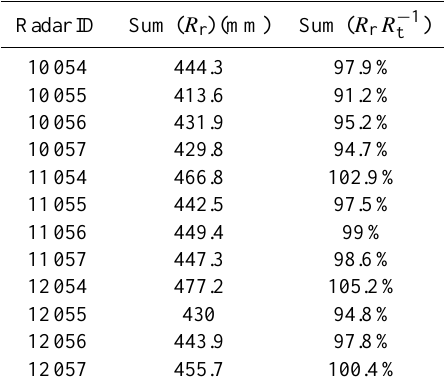
Table 2. Radar pixels after Z – R bias adjustment. Sum ( R r ) repre- sents the accumulated rainfall for the studied period and Sum ( R r R − 1 t ) is the ratio between radar rainfall and rain gauge rainfall (av- eraged over the gauges) for the studied